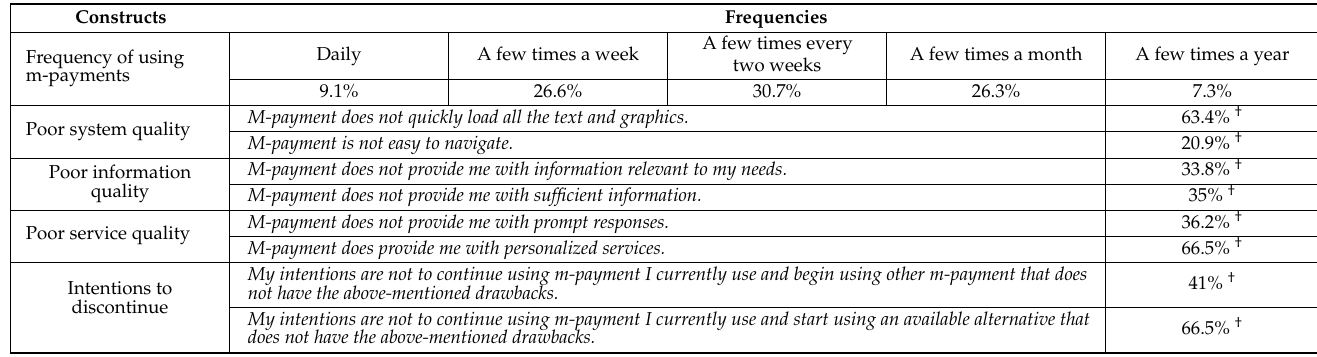
Table A2. Frequency test